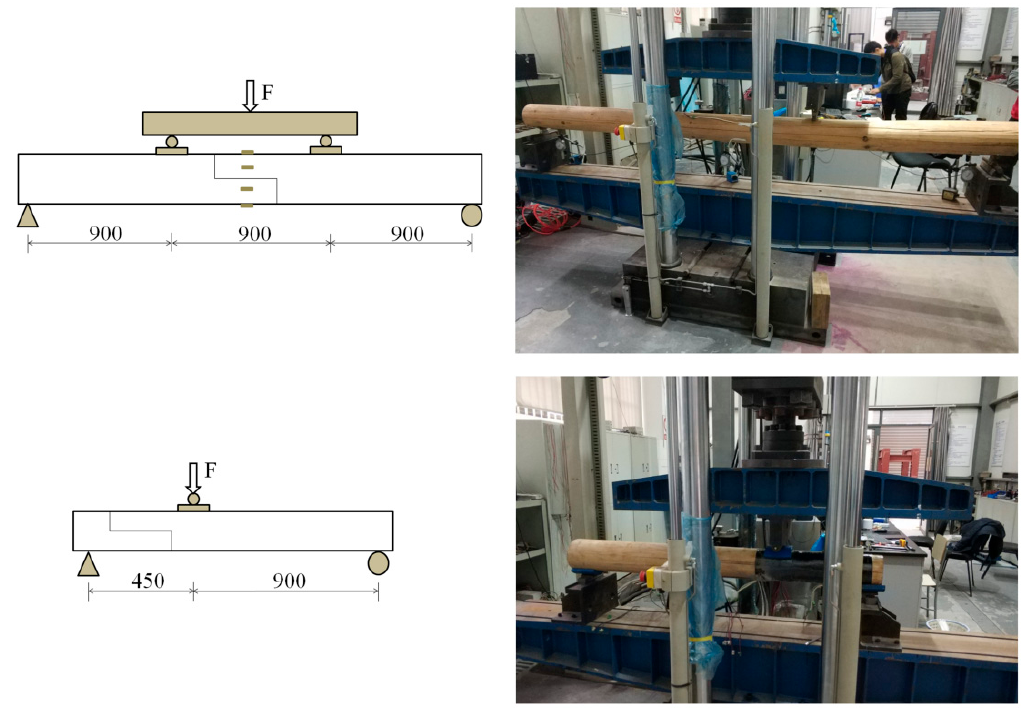
Figure 5. Loading device of load tests (in millimeters).